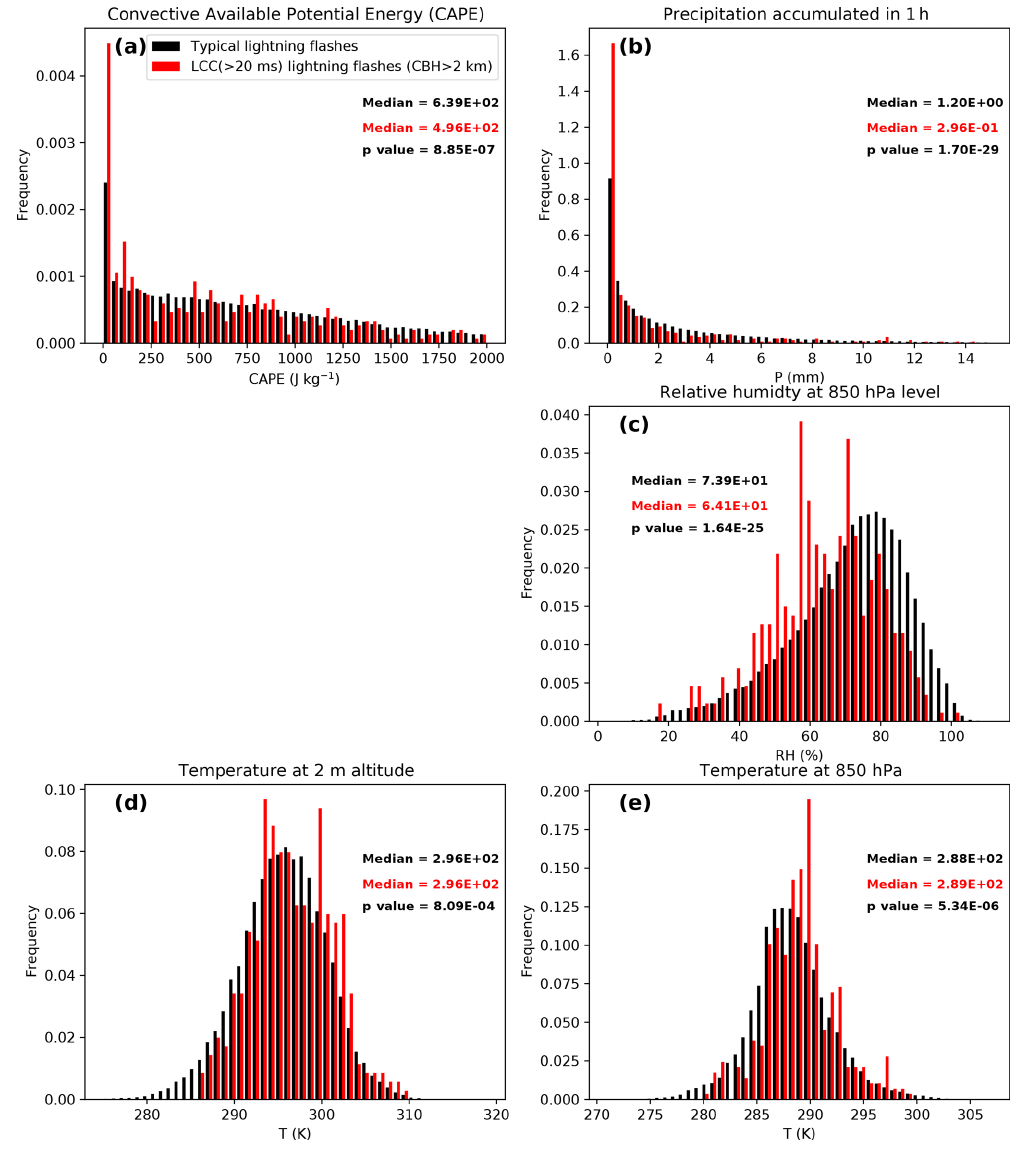
Figure 20. Frequency distribution of the convective available potential energy (CAPE), the hourly accumulated precipitation, the relative humidity at 850hPa level, and the air temperature at 2m and at 850hPa levels for typical lightning and LCC( > 20ms) lightning flashes in high-based thunderclouds (CBH > 2000m), as reported by ISS-LIS over land in Europe between May and September